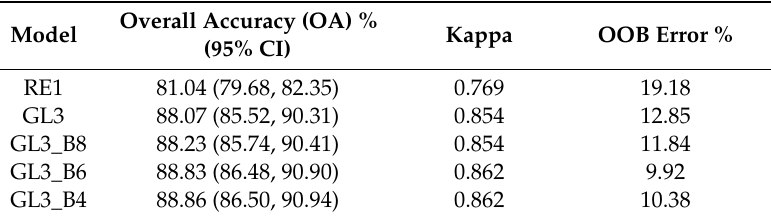
Table 5. The classification results from di ff erent grey level GLCM models and land cover / land use surface area estimates. See Appendix A for details of class errors.